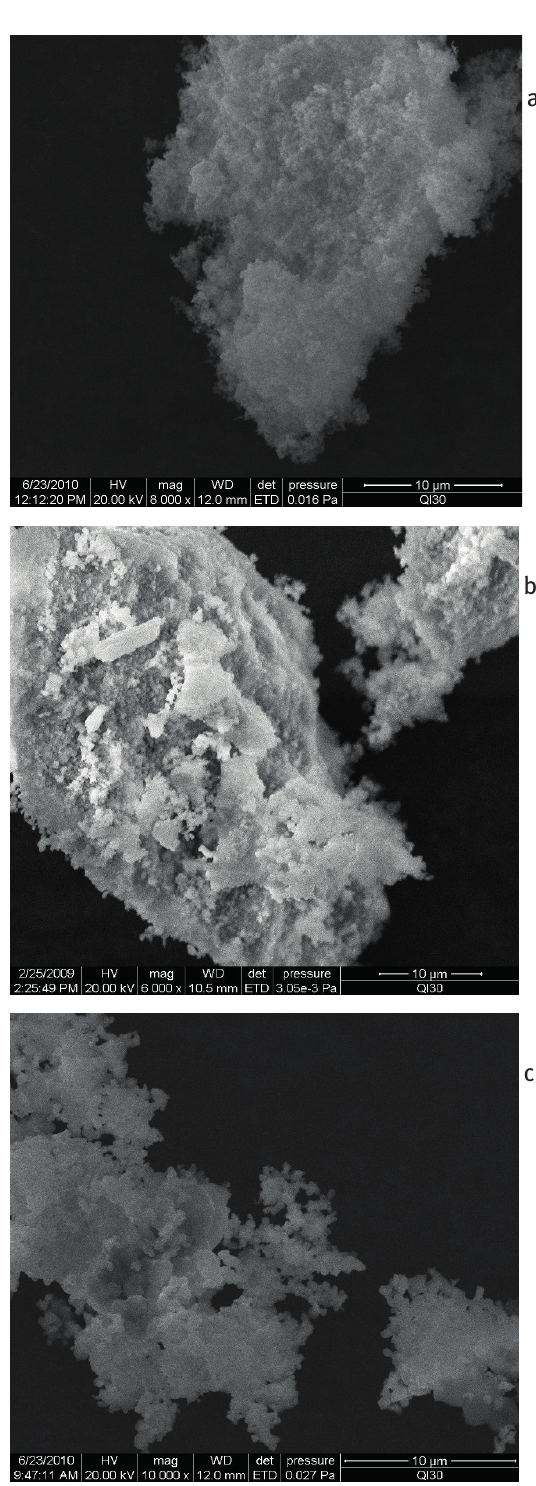
Figure 5: SEM images of HA treated with: (a) 120°C, (b) 1050°C, (c)